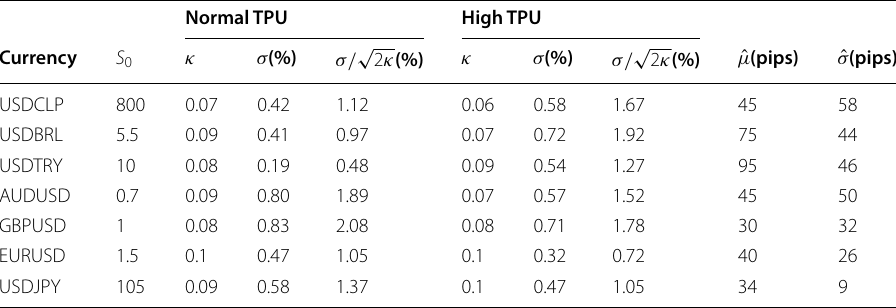
Normal (high) TPU corresponds to the months below (above) the 75th percentile within the sample, which is at µ and σ defining the GBM process of Eq. (13) are obtained from the sample approximately level 47. Estimates of parameters ˆ ˆ of monthly currency returns within the period January 2000 to December 2021. We determine the mean and volatility of returns above the 90th and below the 10th percentile of the sample to capture the degree of the trends (drifts). S 0 is the spot price to be used at the beginning of every simulation. Estimates are shown on a daily scale. 1 pip 10. − =